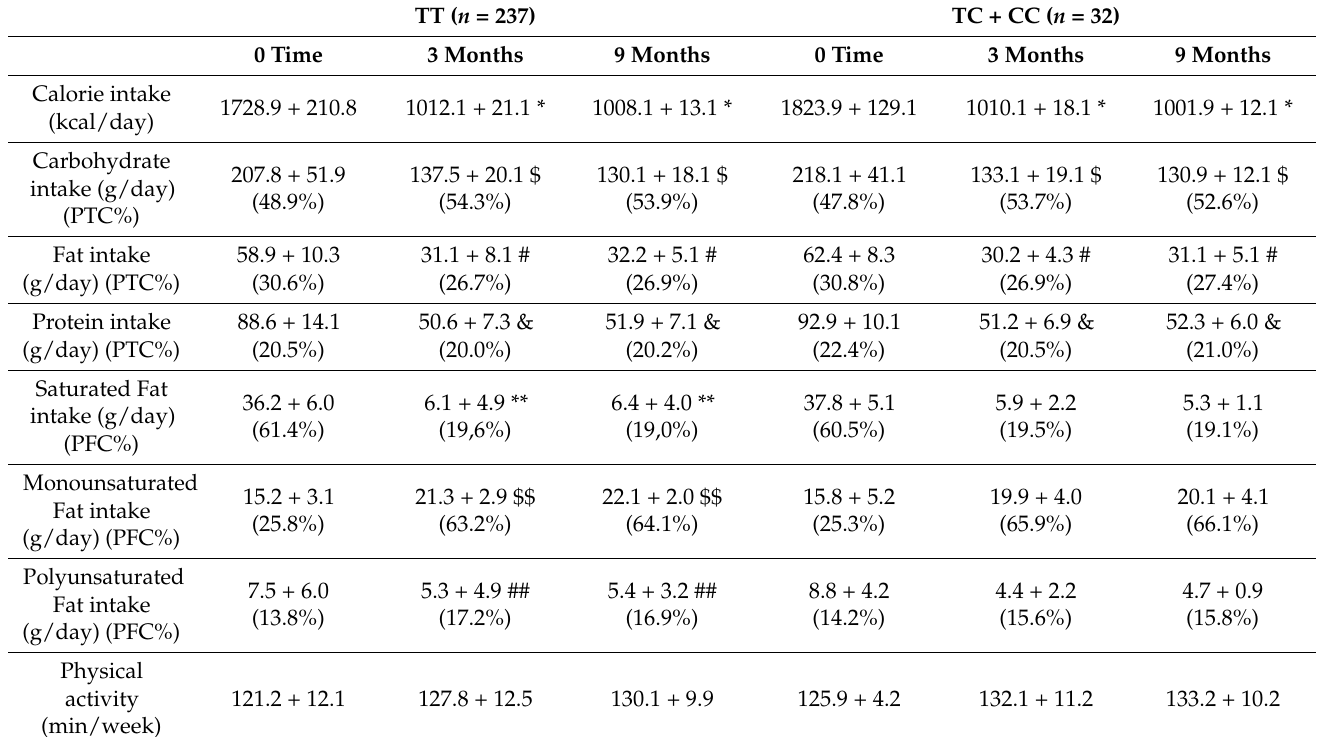
Table 1. Average daily intakes and physical activity determined at three times (basal and 3 and 9 months after the intervention) (mean ± SD).